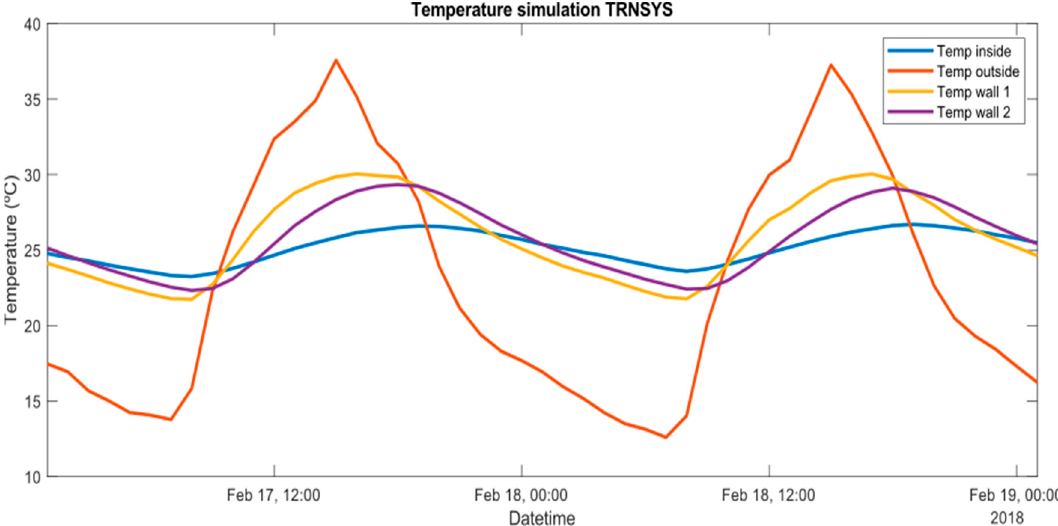
Figure 10. Phase deviation between temperatures.